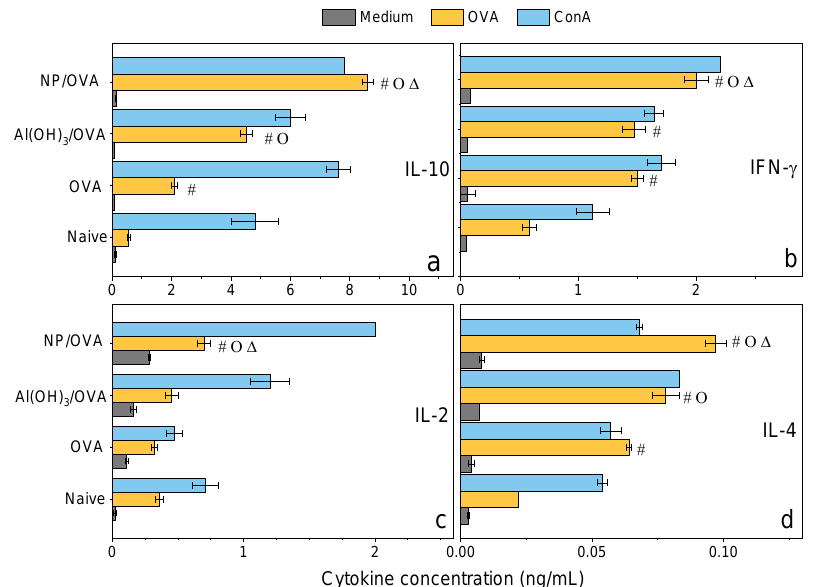
Figure 9. Cytokines profile (ng/mL) from the cultured spleen cells of BALB/c mice, naïve or im- munized with OVA, Al(OH) 3 /OVA, PMMA/DODAB/PDDA/OVA (NP/OVA). p < 0.05 compared to the naive group (#), p < 0.05 compared to the OVA group (o), p < 0.05 compared to the Al(OH) 3 /OVA group (∆). ( a ) IL-10, ( b ) IFN-γ, ( c ) IL-2, ( d ) IL-4. DODAB BF/OVA and PMMA/DODAB/PDDA/OVA yielded a DTH response; Al(OH) 3 /OVA or PDDA/OVA did not elicit a DTH response as previously reported in reference [20] (Figure 8). The NPs/OVA yielded both humoral and cellular immune re- sponses (Figures 7 and 8).